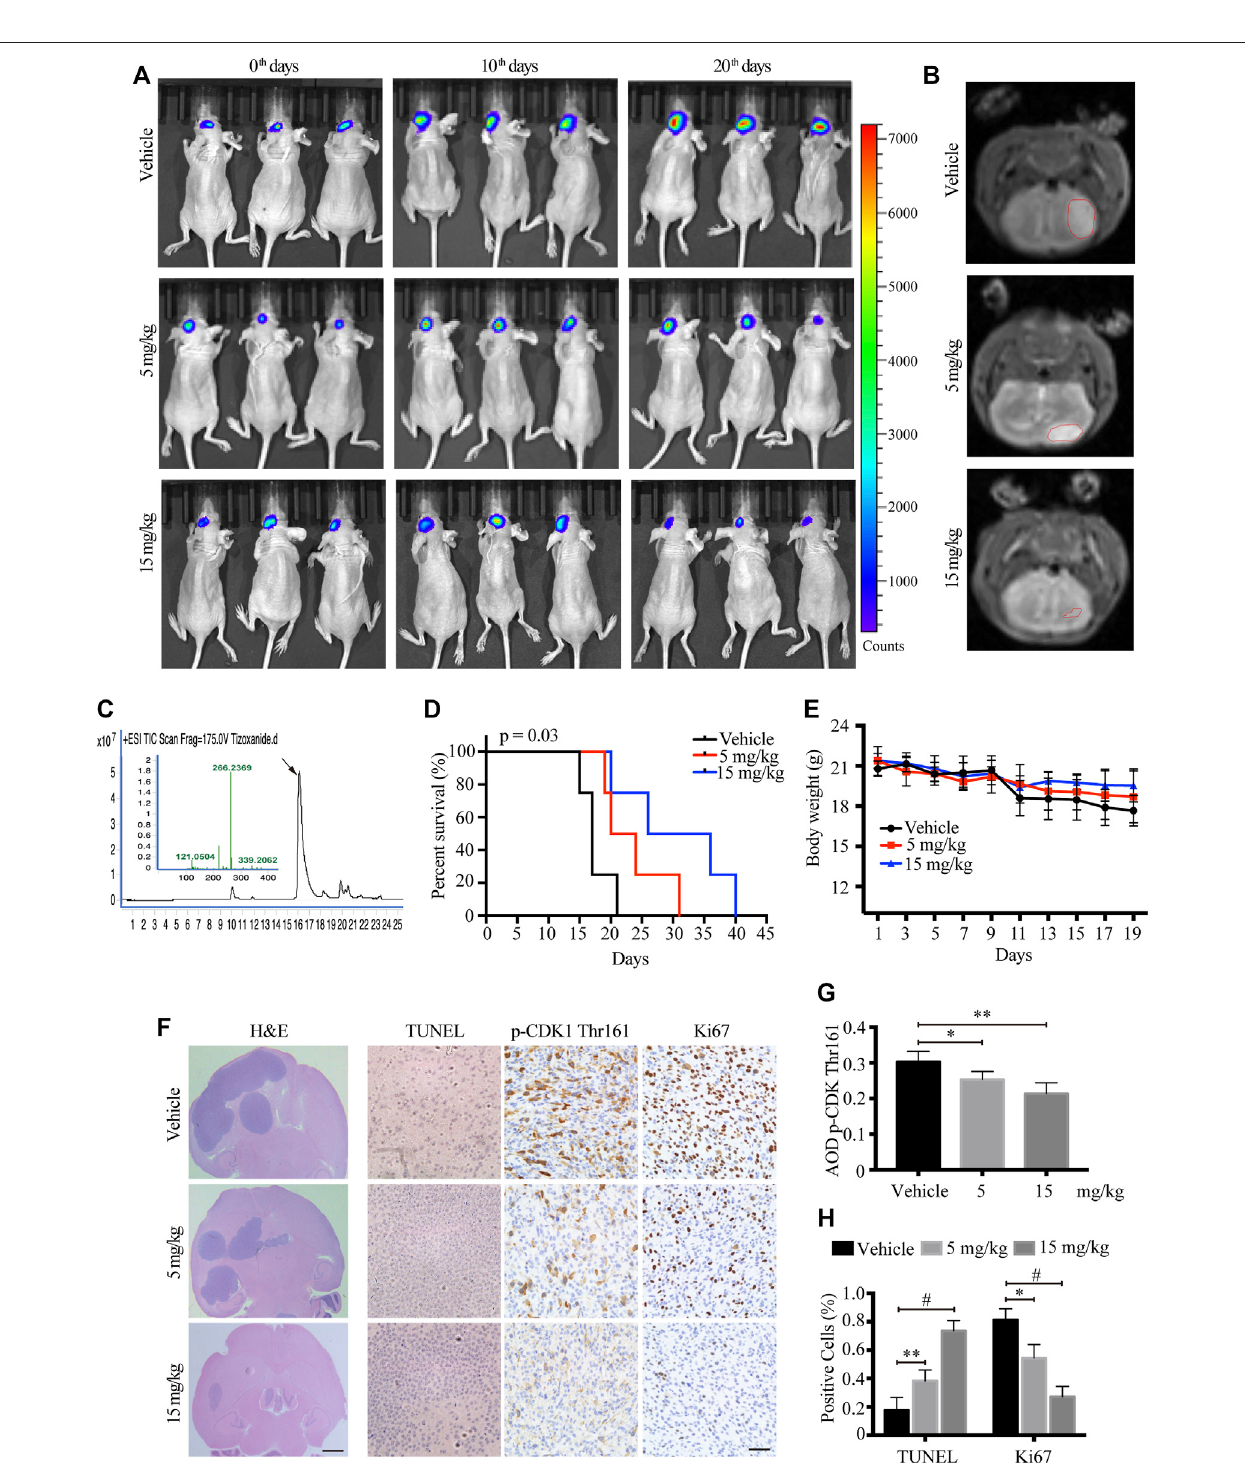
FIGURE 5 | TIZ suppresses the intracranial growth of GBM and elongates mouse survival. (A) IVIS analysis of fl uorescence signal intensity in the brain at different stages of TIZ administration ( n = 12 mice per group). (B) Representative images of brain tumor volume scan by the small animal MRI system. (C) Representative HPLC- MS chromatograms of the concentration analysis of TIZ in the glioma homogenate samples. (D) The survival curves of mice bearing glioma in the brain. (E) Bodyweight curvesofnudemiceduringTIZtreatment. (F) H&E,TUNEL,andp-CDK1Thr161andKi67IHCstainingoftumorslicesinvariousgroups.Scalebar=1 mm(left)and 50 µm (right). Quanti fi cation of IHC staining of p-CDK1 Thr161 (G) and positive TUNEL and Ki67 staining (H) ( n = 5).